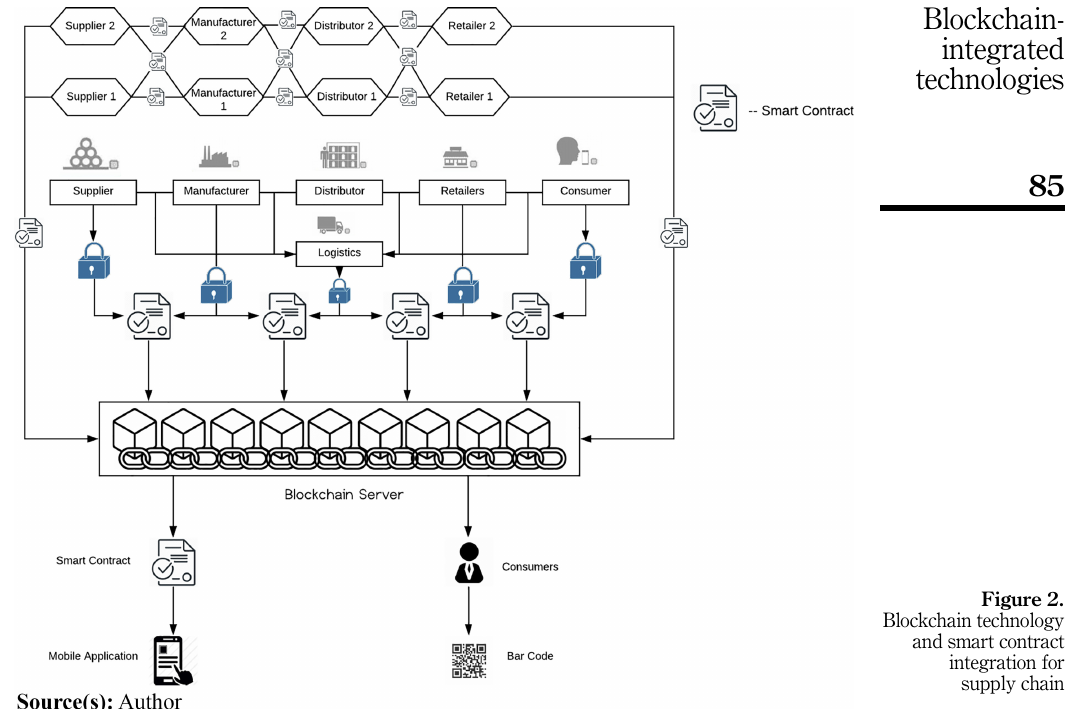
Figure 2. Blockchain